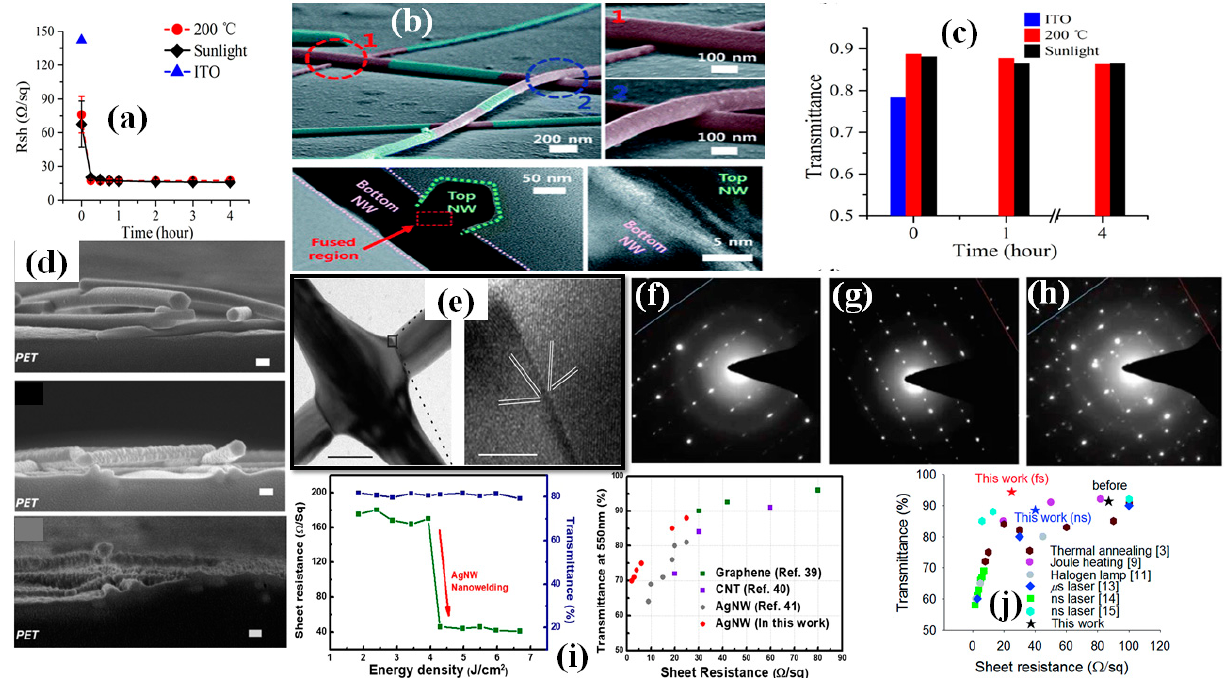
Figure 23. ( a ) Sheet resistance (Rsh) as a function of treatment time for samples treated with Sun sunlight illumination (black diamonds) and thermal annealing at 200 °C (red circles), respectively. (adapted from [249] with permission from Springer nature, 2017). ( b ) Magnified SEM (pseudo-colored) and HRTEM images Laser nano-welding of very long Ag NW network electrodes for highly transparent and flexible electrodes. (adapted from [164] with permission from Royal society of chemistry 2012). ( c ) Histogram of the light transmittance at 550 nm before and after different periods of time for both treatment methods (ref. [250])Cross-sectional SEM images of AgNW films on PET substrates ( d ) before and after HIPL sintering with light intensities of 1.14 and 2.33 Jcm − 2 , respectively. (adapted from [248] with permission from Springer nature, 2017). ( e )TEM images of AgNW junctions after optical welding, merged planes can be seen in HRTEM image ( f ) SAED pattern of the top nanowire away from the junction. The large number of double diffractions caused by the pentagonally twinned cross-section lead to prominent lines of spots in only one direction, parallel to the blue line ( g ) SAED pattern of the bottom nanowire away from the junction. The double diffraction spots occur in a direction roughly perpendicular to that in b and parallel to the red line. ( h ) SAED pattern of the junction. Both sets of spots from b and c are visible. The double diffraction spots create a grid instead of an array of parallel lines as in g and h. (adapted from [251] with permission from Springer nature, 2012). ( i ) Sheet resistance and transmittance response to the flash light method induced nanowelding and Resulting sheet resistance and transmittance values compared to reference values from literature Improved optoelectronic properties on a stretchable PDMS electrode were achieved after xenon flash lamp treatment as shown in Figure 23i. (adapted from [253] with permission from Royal society of chemistry, 2016). ( j ) Comparison of the transmittance and sheet resistance with the previously reported results (adapted from [158] with permission from Springer nature